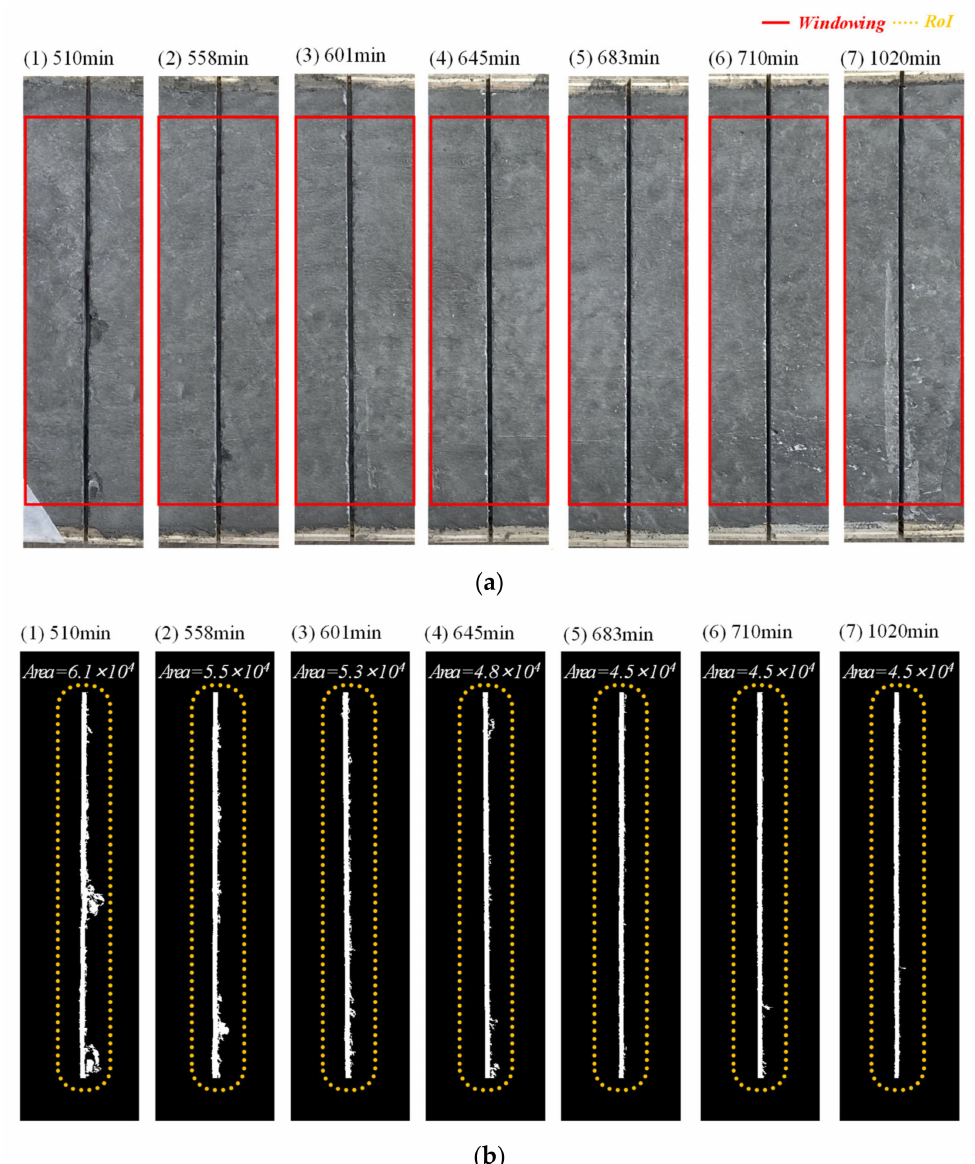
Figure 8. Saw cut damage identification: ( a ) saw cut images cropped from photos, and ( b ) the corresponding binarized images. Note that the red solid box indicates the windowed region, and the yellow box indicates the